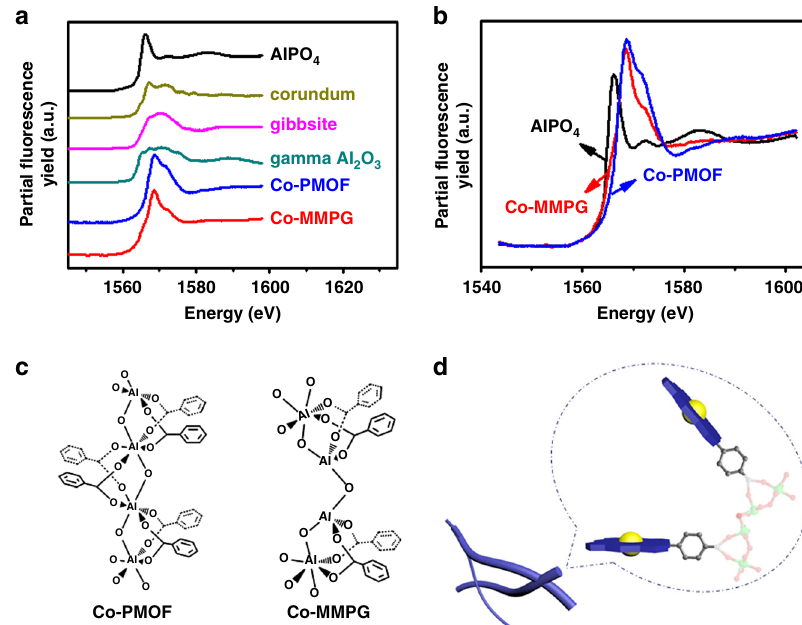
Fig. 3 Coordination environment around Al(III). a Al K-edge XANES spectra of types of Al(III)-based samples, including AlPO 4 , corundum( α -Al 2 O 3 ), gibbsite(Al(OH) 3 ), gamma Al 2 O 3 ( γ -Al 2 O 3 ), Co-PMOF, and Co-MMPG; b Al K-edge XANES spectra of types of Al(III)-based samples including AlPO 4 , Co- PMOF, and Co-MMPG; c the local structure of Co-PMOF based on single X-ray data 39 and Co-MMPG based on XANES spectra; d the proposed local structure of Co-MMPG. Source data are provided as a Source Data fi